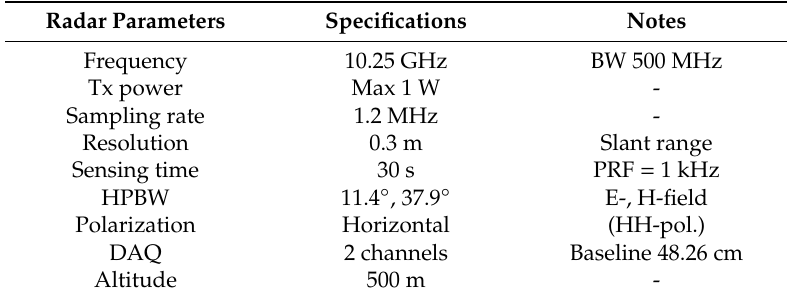
Table 1. Specification of an airborne FMCW SAR